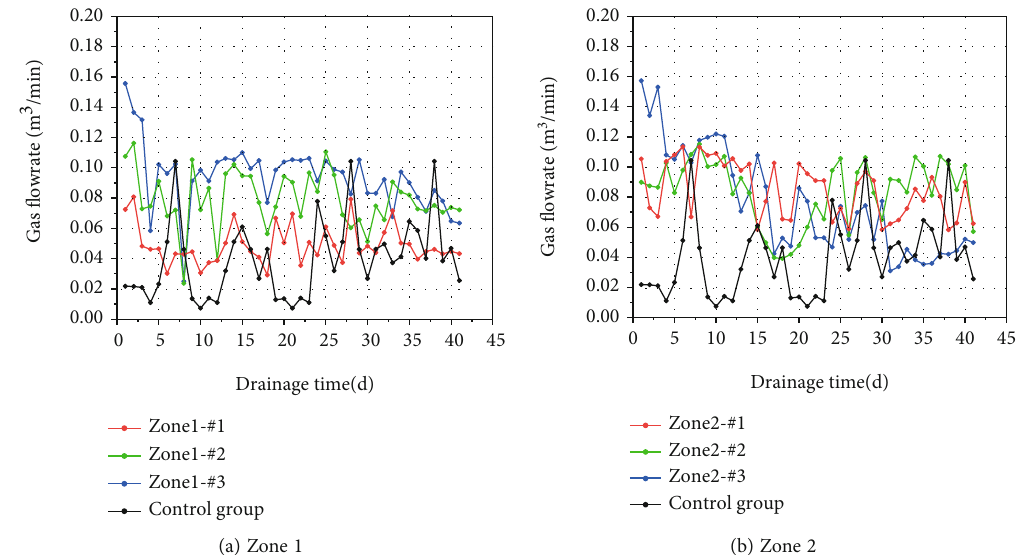
Figure 4: Change curves of the gas fl owrate in drainage borehole.